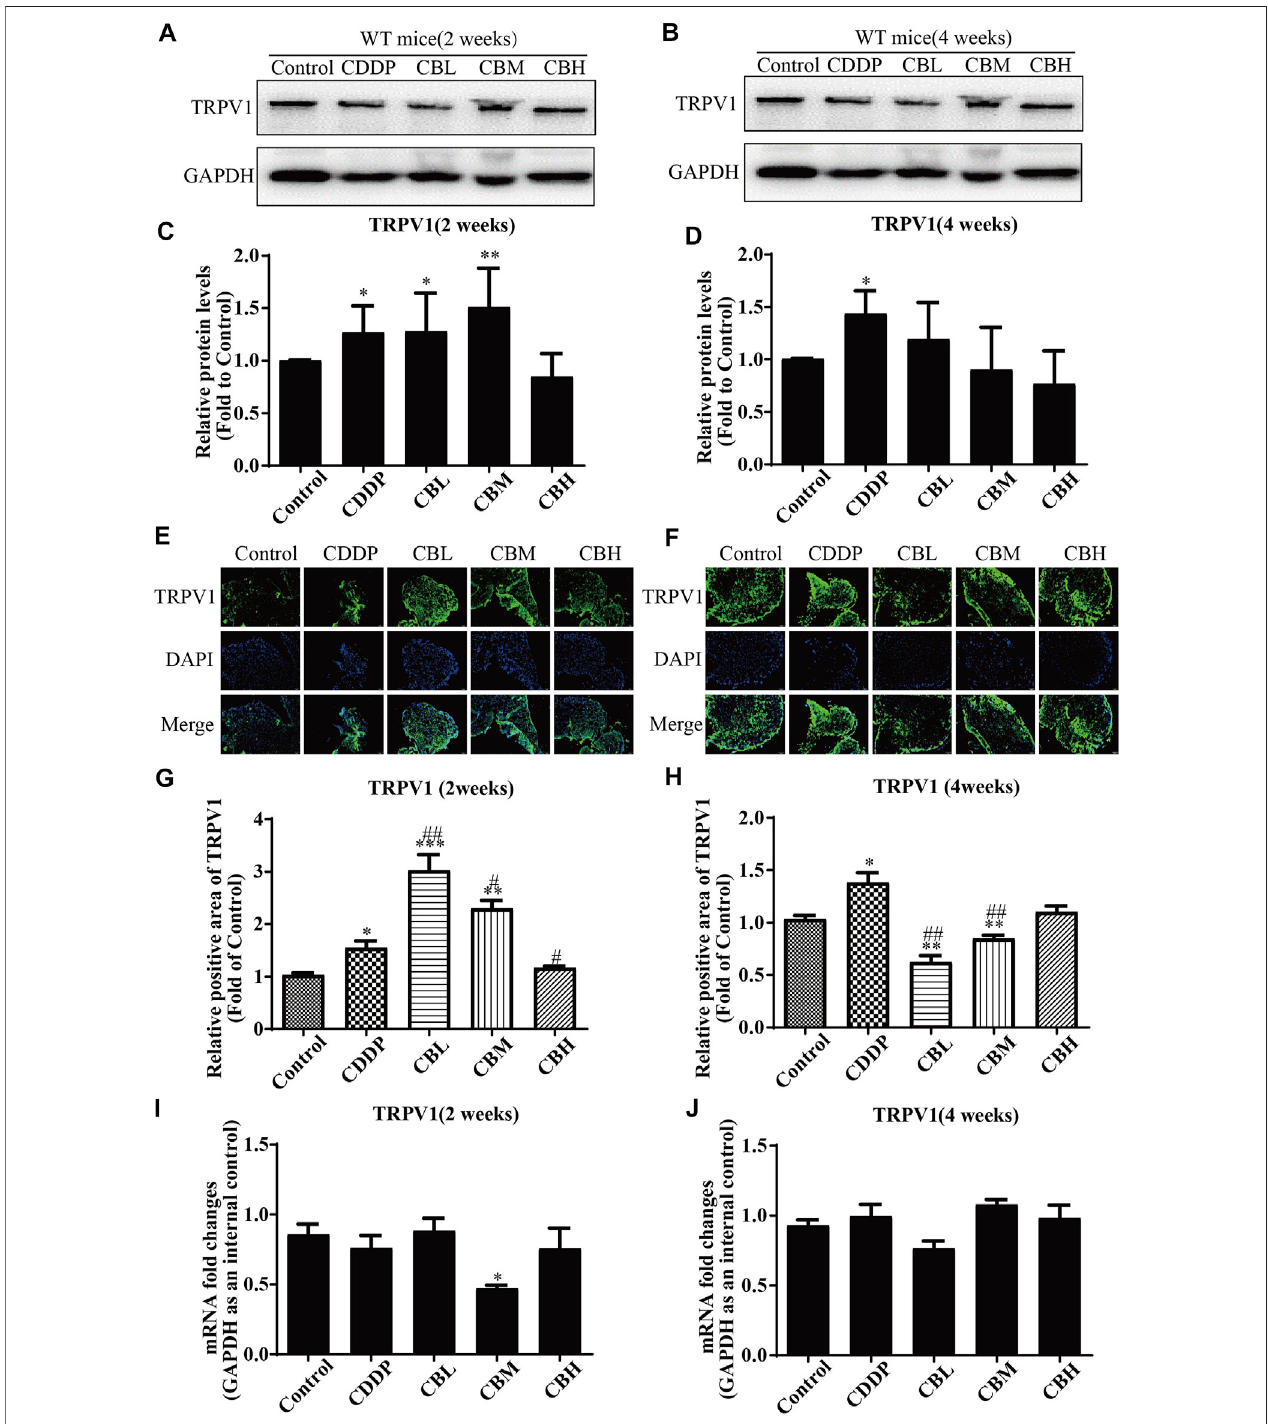
FIGURE 4 | BBR inhibits up-regulation of TRPV1 protein in CDDP-induced DRG of WT mice. (A,C) Western blot results and their quantitative data show CDDP induced TRPV1 up-regulation in spinal DRG for 2 weeks. (B,D) Western blot results and their quantitative data show CDDP induced TRPV1 up-regulation lasted for 4 weeks, and BBR inhibited TRPV1 over-expression in DRG after 4 weeks of treatment. (E,G) Immuno fl uorescence results and their quantitative data show CDDP induced TRPV1 up-regulation in DRG for 2 weeks. (F,H) Immuno fl uorescence results and their quantitative data show CDDP induced TRPV1 up-regulation lasted for 4 weeks, and BBR inhibited TRPV1 over-expression in DRG after 4 weeks of treatment. Statistical analysis was performed using one-way ANOVA (* p < 0.05, ** p < 0.01,*** p < 0.001,comparedwiththecontrolgroup; # p < 0.05, ## p < 0.01, ### p < 0.001,comparedwiththeCDDPgroup).CBL:CDDP+BBRlowdose;CBM:CDDP+ BBR medium dose; CBH: CDDP + BBR high